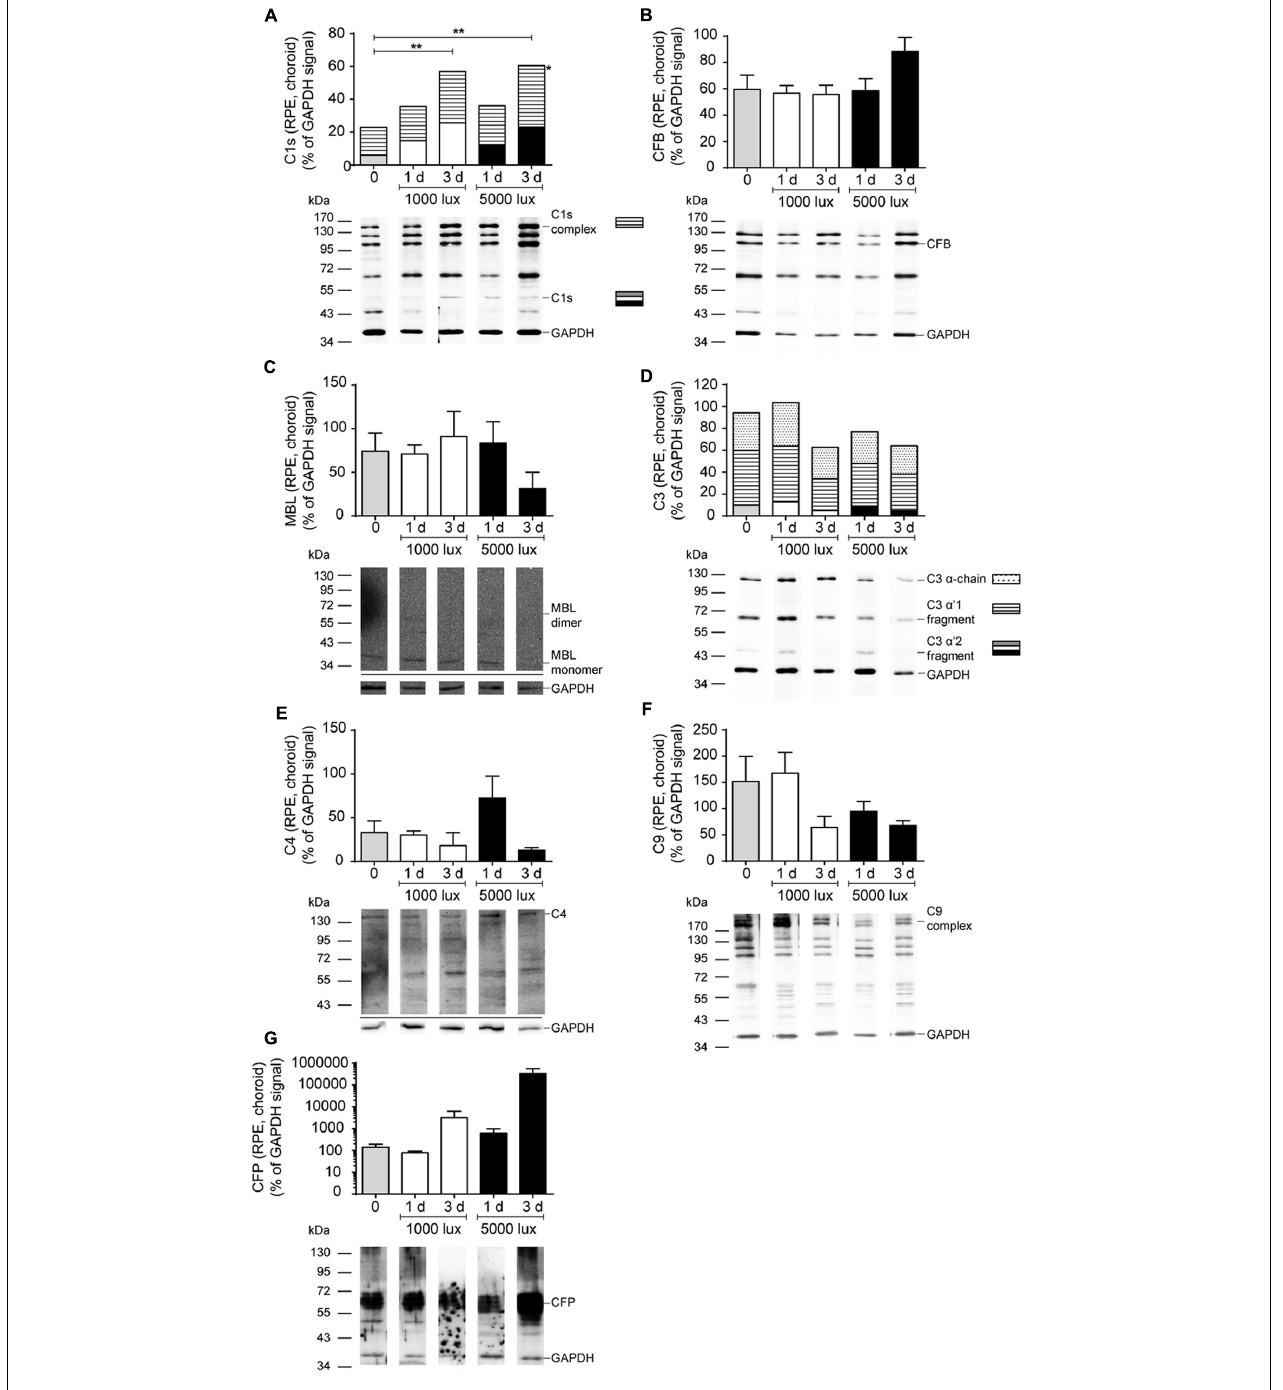
FIGURE 6 | Increased C1s-complex and decreased C9-complex deposition in the RPE/choroid after LD. Complement protein expression of (A) C1s (see also Supplementary Figure S7D), (B) CFB (see also Supplementary Figure S7C), (C) MBL (see also Supplementary Figure S7F), (D) C3 (see also Supplementary Figure S7A), (E) C4 (see also Supplementary Figure S7H), (F) C9 (see also Supplementary Figure S7E), and (G) CFP (see also Supplementary Figure S7G) in the RPE/choroid of mice either treated with constant (1000 lux, 24 h; white bars) or acute white light (5000 lux, 0.5 h; black bars) was compared to untreated controls (gray bars) in Western blot. (A,D) Stacked bars correspond to different molecular weights of protein fragments. Data represent mean percentages of the GAPDH control signal of 4–6 mice of each treatment group. Exemplarily Western blots are shown for complement protein detection in one mouse tissue, respectively (for entire blots see Supplementary Figure S7). Blots were sequentially developed (Supplementary Figure S4). ∗∗ 0.001 < P < 0.01 (ordinary one-way ANOVA, Dunnett’s multiple comparisons test, with a single pooled